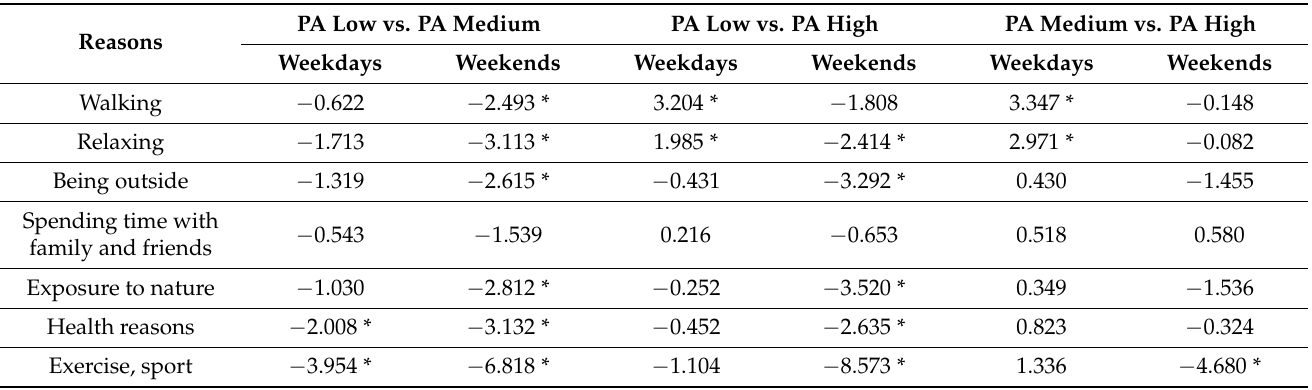
Table 2. Reasons for using green spaces comparison of people with different activity levels (pairwise comparisons using the Mann-Whitney U-value Z-test).